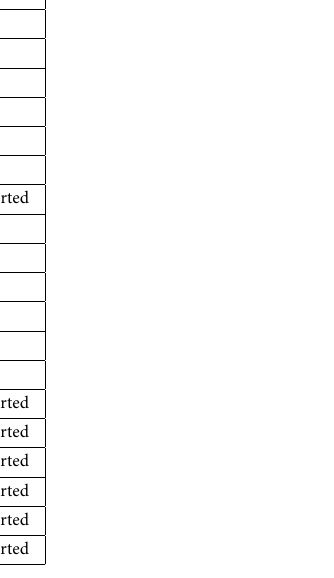
Table 2. Significance-based summary of the